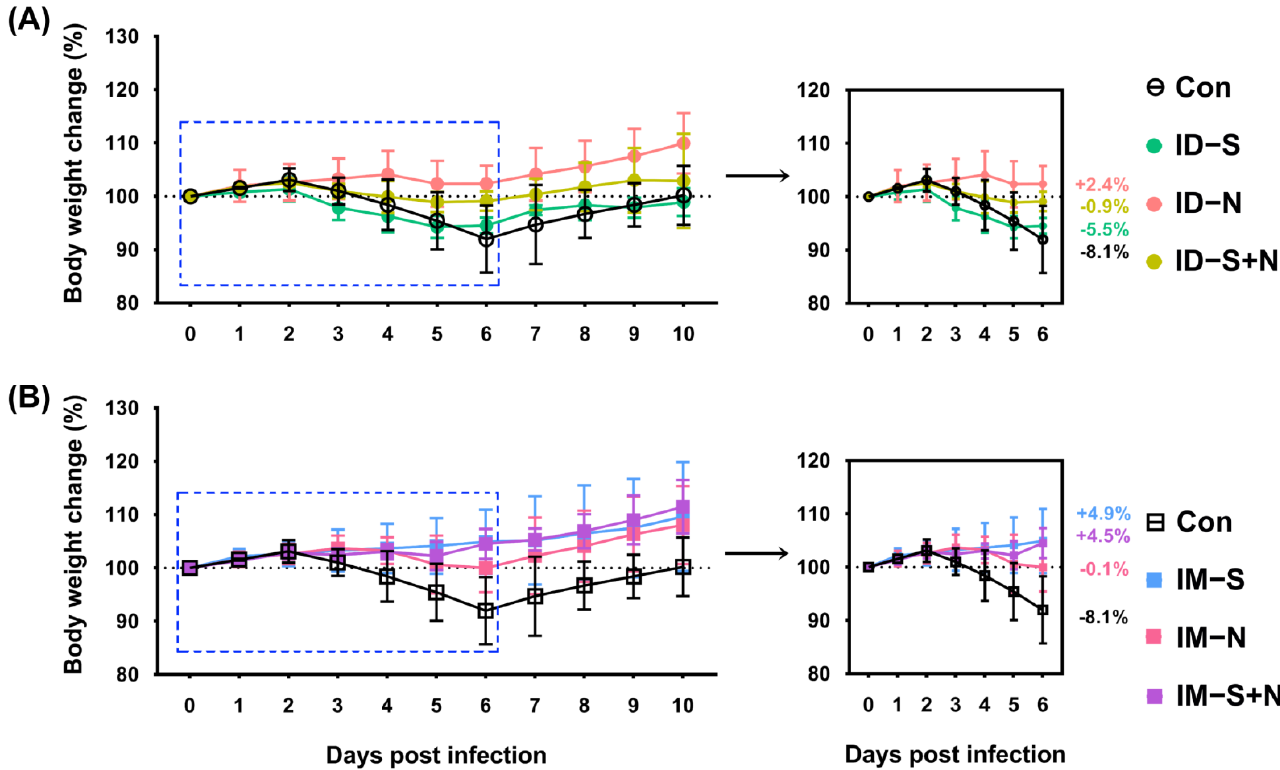
Figure 3. The changes in weight of hamsters immunized with the recombinant proteins via the ID and IM routes during SARS-CoV-2 challenge. ( A ) Challenge after ID and ( B ) challenge after IM. Changes in body weight after virus challenge within 10 days (left) and 6 days (right) are shown. Con: control group; ID-S: immunized with the S protein via ID administration; ID-N: immunized with the N protein via ID administration; ID-S + N: immunized with S/N mixed protein via ID administration; IM-S: immunized with the S protein via IM administration; IM-N: immunized with the N protein via IM administration; IM-S + N: immunized with S/N mixed protein via IM administration. The average weight change of each group on the 6th day after challenge is indicated as a colored number. Data are means ± SDs ( n = 10 per